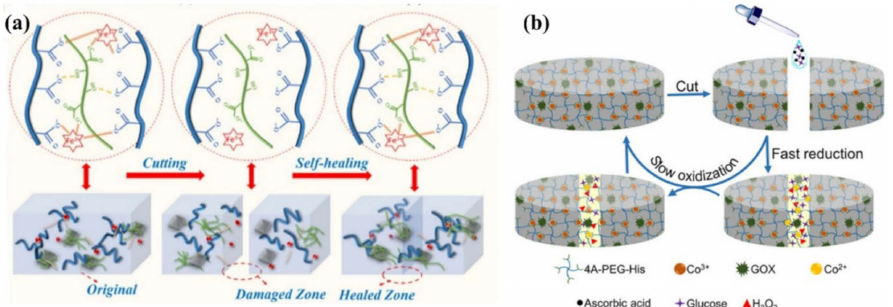
Figure 23. ( a )Schematicrepresentationoftheself-healingmechanismofhydrogels. Reproducedfrom[156] with permission from Elsevier. ( b ) Schematic of glucose oxidase (GOX)-regulated transient healing of cobalt cross-linked polymer networks. Reprinted with permission from [157]. Copyright (2020) American Chemical Society.